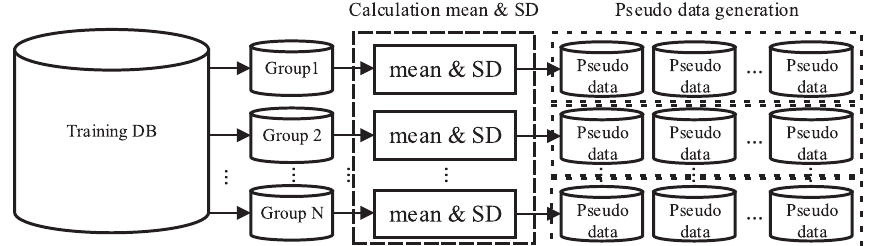
Figure 2. Block diagram of the bootstrap